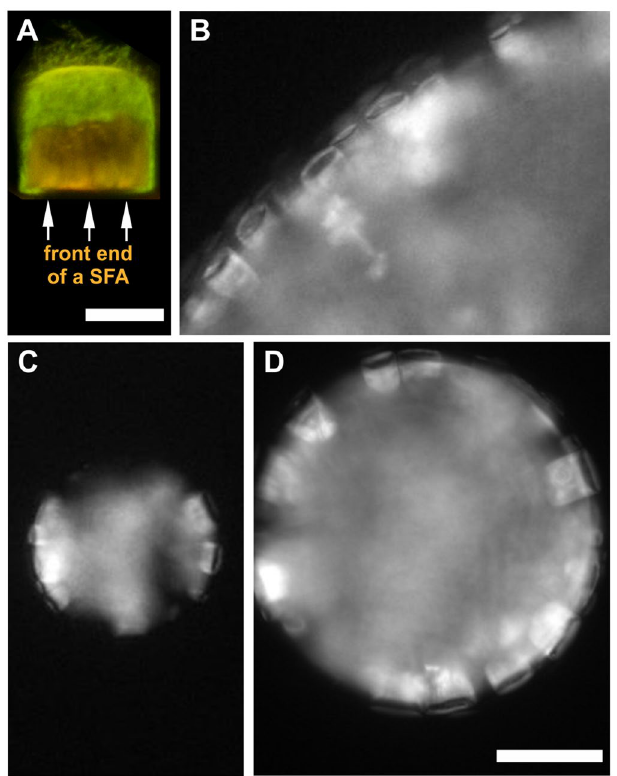
Figure 8. Alignment of α S SFAs at oil/water interface. ( A ) Ratiometric confocal fluorescence image of an α S SFA containing aS140C-MFM. The ratiometric image indicates that the outer layers of the SFAs are more polar than the inner parts. ( B – D ) Epi-fluorescence images of SFAs prepared in 10 mM Tris, 2 mM CaCl 2 and 100 μ M α S stained with ThT and re-suspended in 2 vol% water/n-dodecane emulsion. Under these conditions the SFAs localize in the water phase but remain in contact with the oil phase by exposing their front parts to it. This indicates a more apolar interior of the aggregate. At the front of the SFAs a large part of the interior is exposed to the solvent (shown in A ). Scale bars are 25 μ m ( A ) and 100 μ m ( D